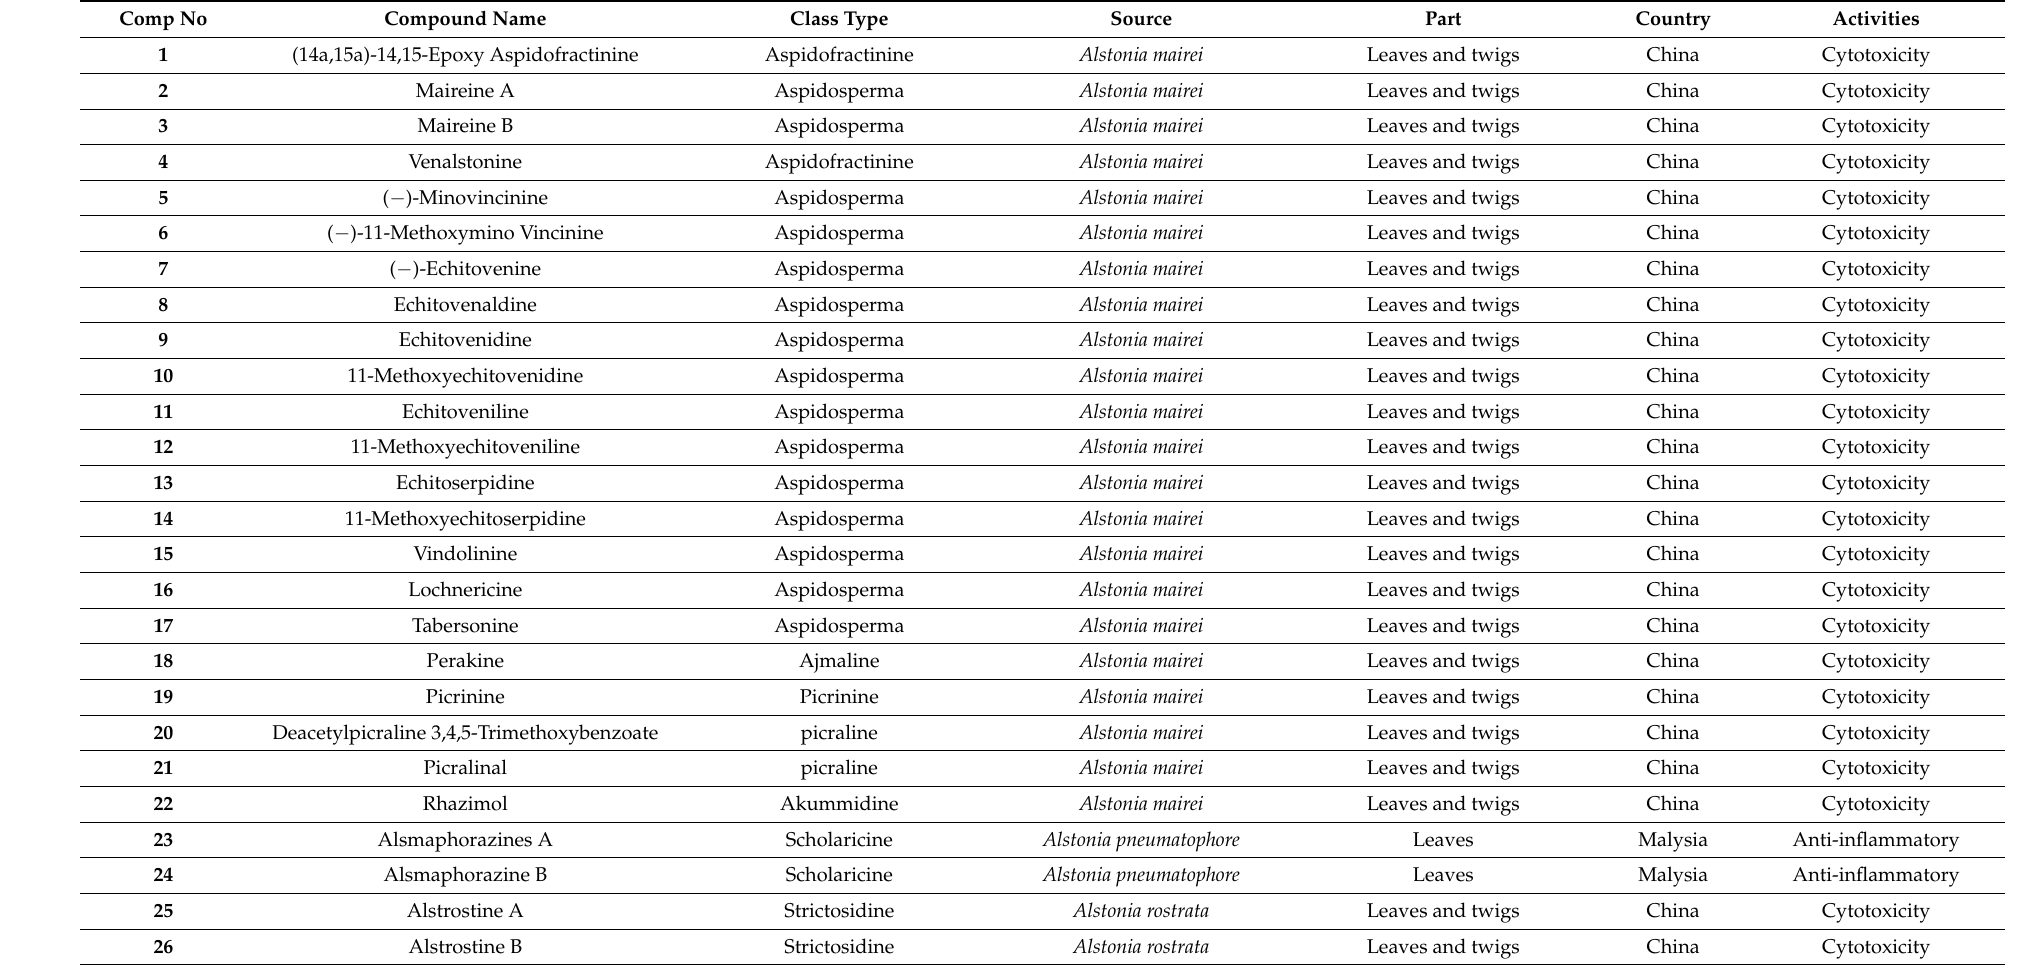
Table 1. Monoterpenoid indole alkaloids from the six species of